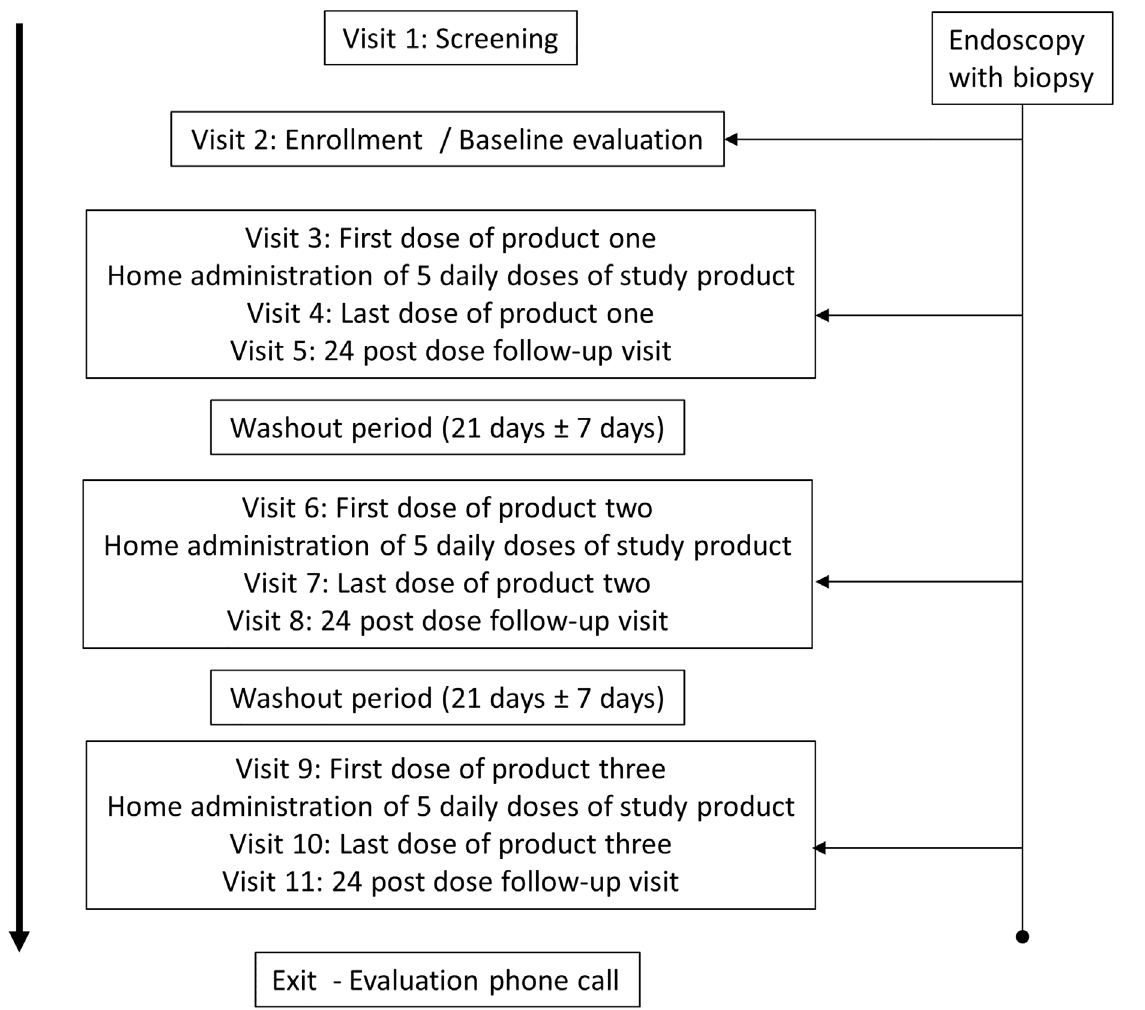
Fig 1. CHARM-01 study